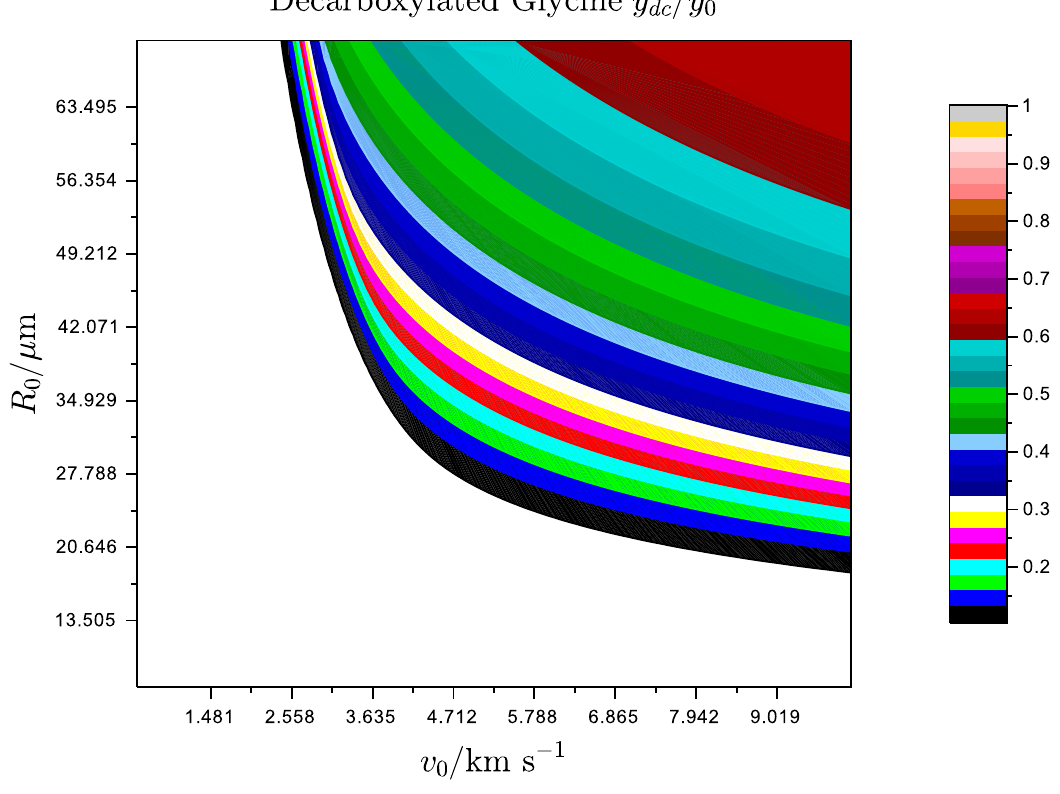
Figure 8. Contour lines of the relative fraction of decarboxylated amino acid y dc / y 0 (0.08 ≤ y dc / y 0 ≤ 0.81) calculated with L = 3.574 × 10 − 11 m, D 0 = 1.0 × 10 − 12 m 2 s − 1 , and θ 0 = 45.0 deg versus the initial velocity and radius of micrometeoroids with 0.5 ≤ v 0 ≤ 10.0 km s − 1 and 7 ≤ R 0 ≤ 70 µ